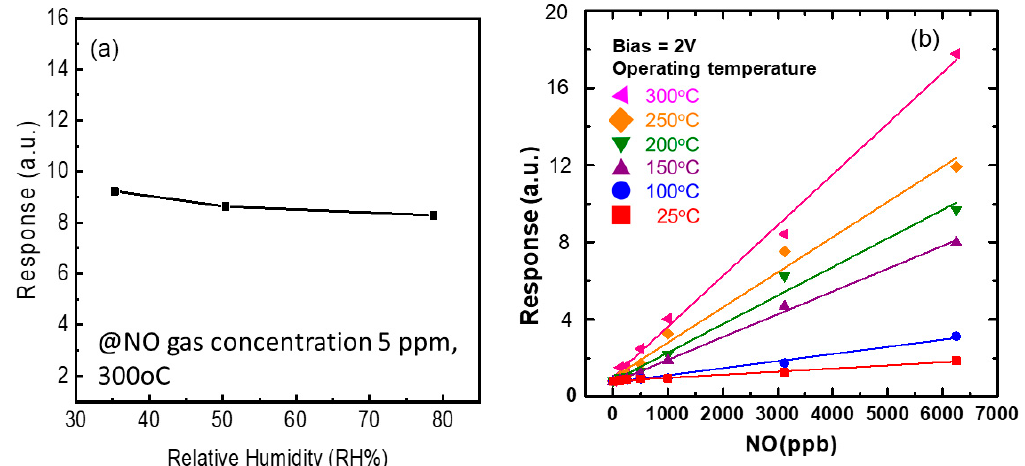
Figure 8. Response of ZGO gas sensor ( a ) as function of relative humidity measured at 5 ppm of NO concentration and ( b ) as function of NO concentration operated at different temperature.